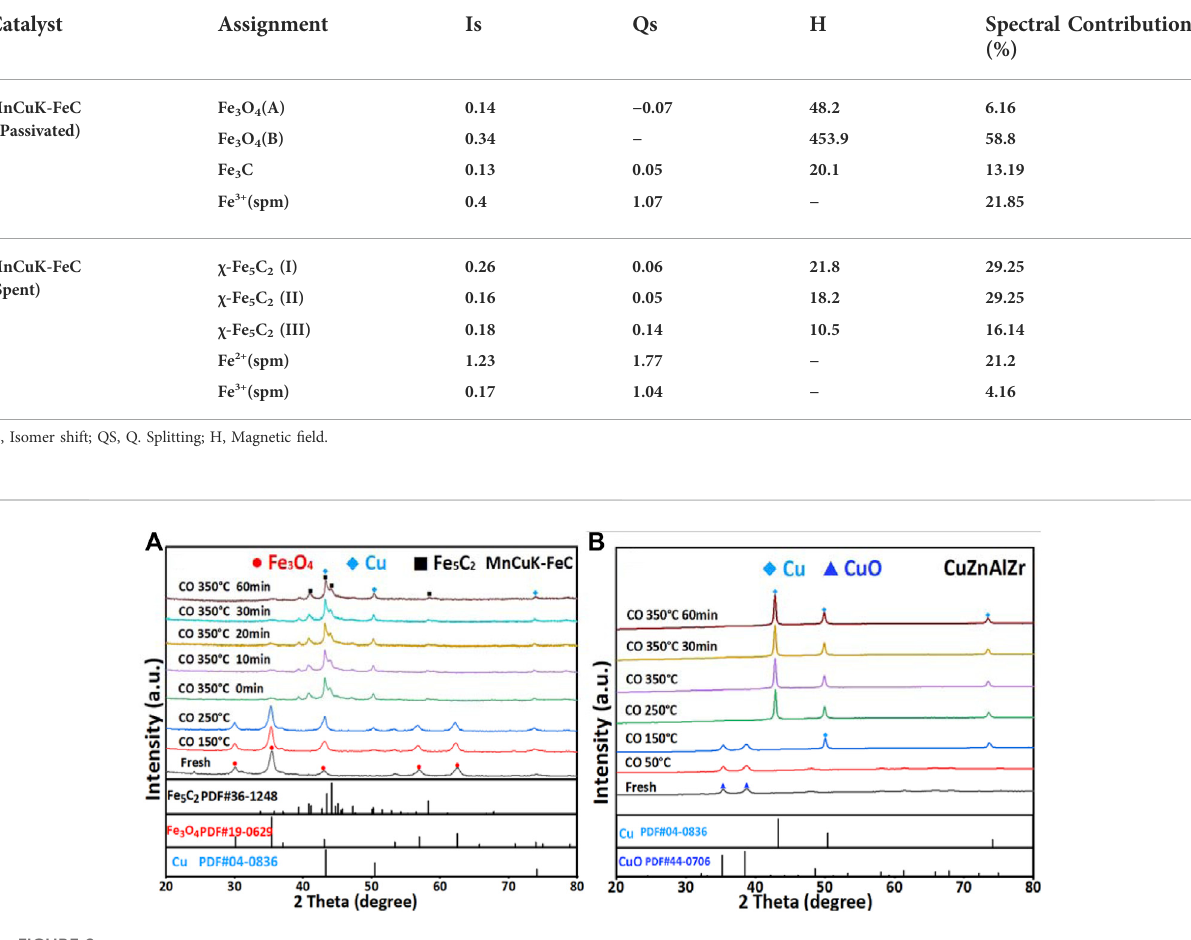
TABLE 1 Mössbauer parameters of catalysts. Catalyst